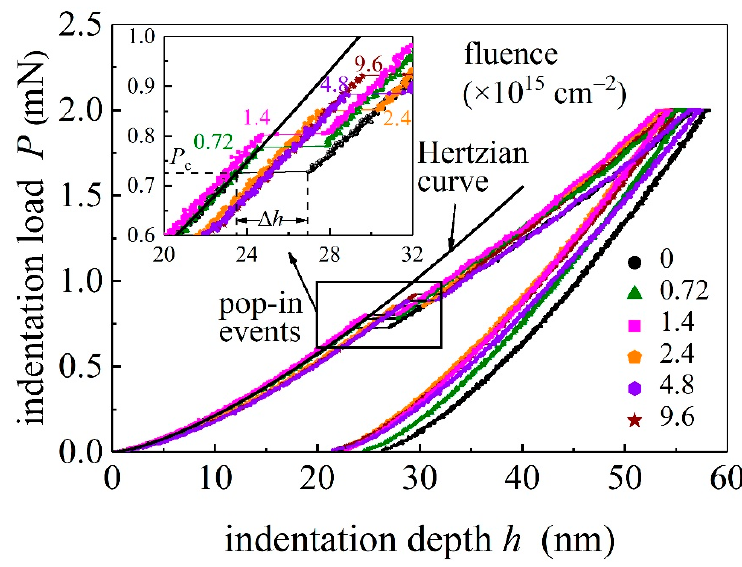
Figure 2. Load–depth ( P ‐ h ) curves for GaN single crystals obtained from the nanoindentation experiments with maximum load of 2 mN. The GaN samples are subjected to different values of ion fluence D from 0.72 × 10 15 cm − 2 to 9.6 × 10 15 cm − 2 . The inset shows pop ‐ in events in the loading parts of the P ‐ h curves.